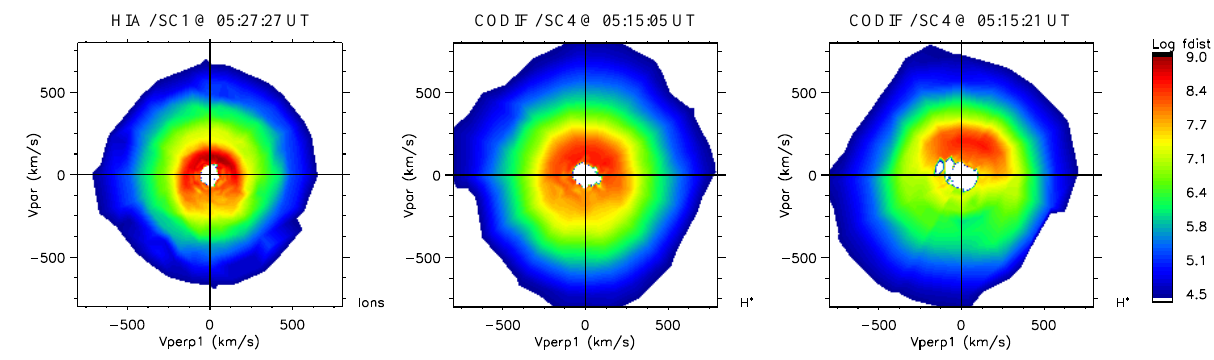
Fig. 7. Ion distribution functions in parallel/perpendicular-plane (from HIA-instrument) at 05:27:27 UT (a) . Proton distribution functions (from CODIF-instrument) at sc4 (at 05:15:01 UT (b) and at 05:15:21 UT (c) ),